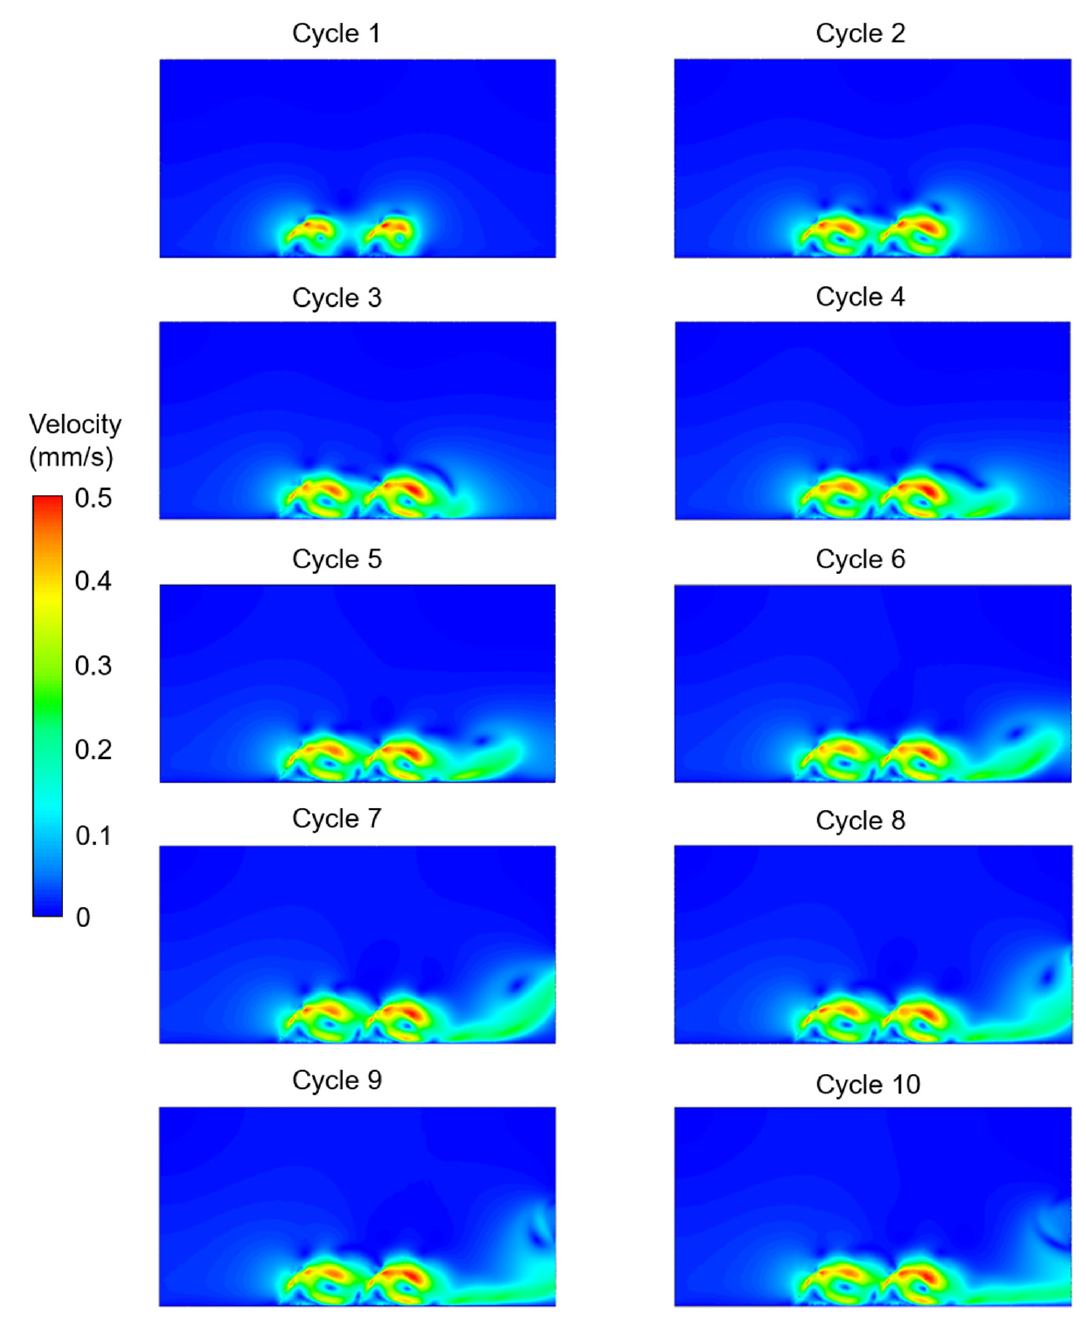
Figure 6. Velocity contour plots of Case 4 for two cilia with a 60° cilium tilt angle. The cilia beat synchronously (in phase) without any phase difference in time. The flow fields are provided at the end of each ciliary cycle.